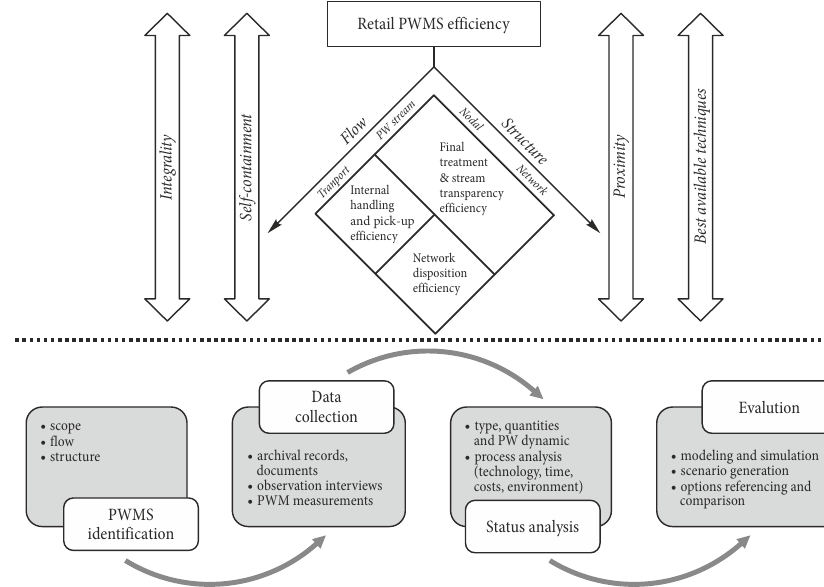
Figure 3. Employed analytical framework and methodology with PWMS